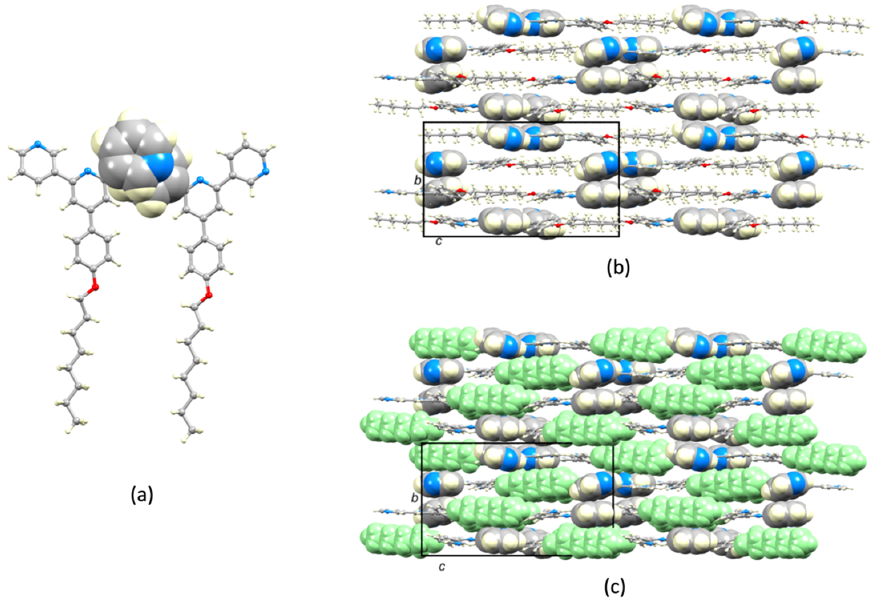
( a ) Face-to-face π -stacking between pyridine rings (space-filling representation) of crystallographically independent molecules of 8 . ( b ) Molecules of 8 pack into 2D-layers with the n -octyloxy chains in extended conformations, and ( c ) the same view of the packing as in ( b ) with the n -octyloxy groups in space-filling representation (green).